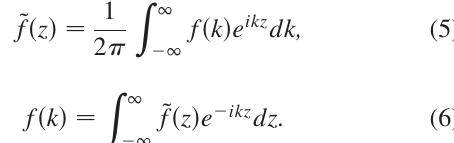
and x , a b (cid:2) x , where b a